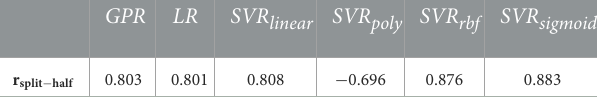
TABLE 4 Ablation studies with different modeling features.